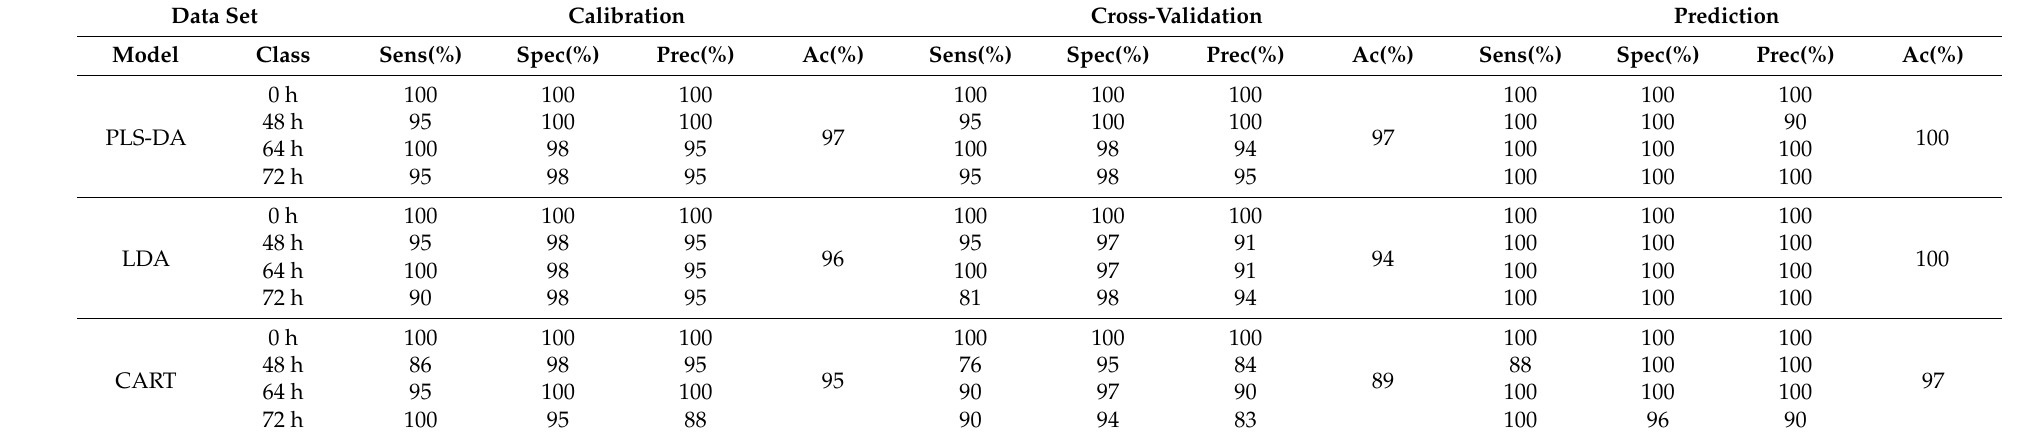
Table 3. Discrimination results for C. fimbriata -infected sweetpotatoes by PLS-DA, LDA, and CART at 0 h, 48 h, 64 h, and 72